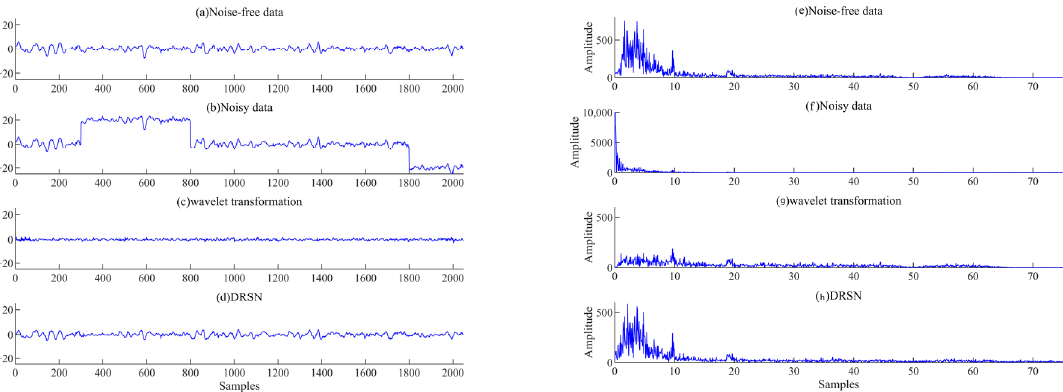
Figure 9. Denoising results for the data with step-wave noise. Time domain waveform of ( a ) Noise-free data, ( b ) Noisy data the results of ( c ) wavelet transformation, ( d ) DRSN. Spectrum of ( e ) Noise-free data, ( f ) Noisy data, the results of ( g ) wavelet transformation, and ( h ) DRSN.